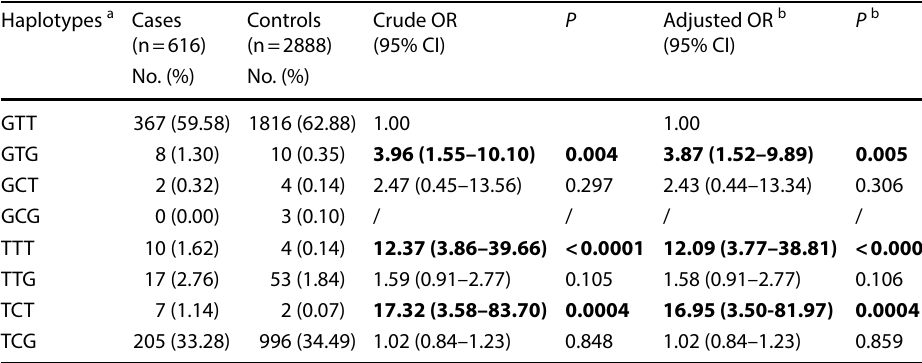
Table 3 Association between inferred haplotypes of METTL1 gene and hepatoblastoma